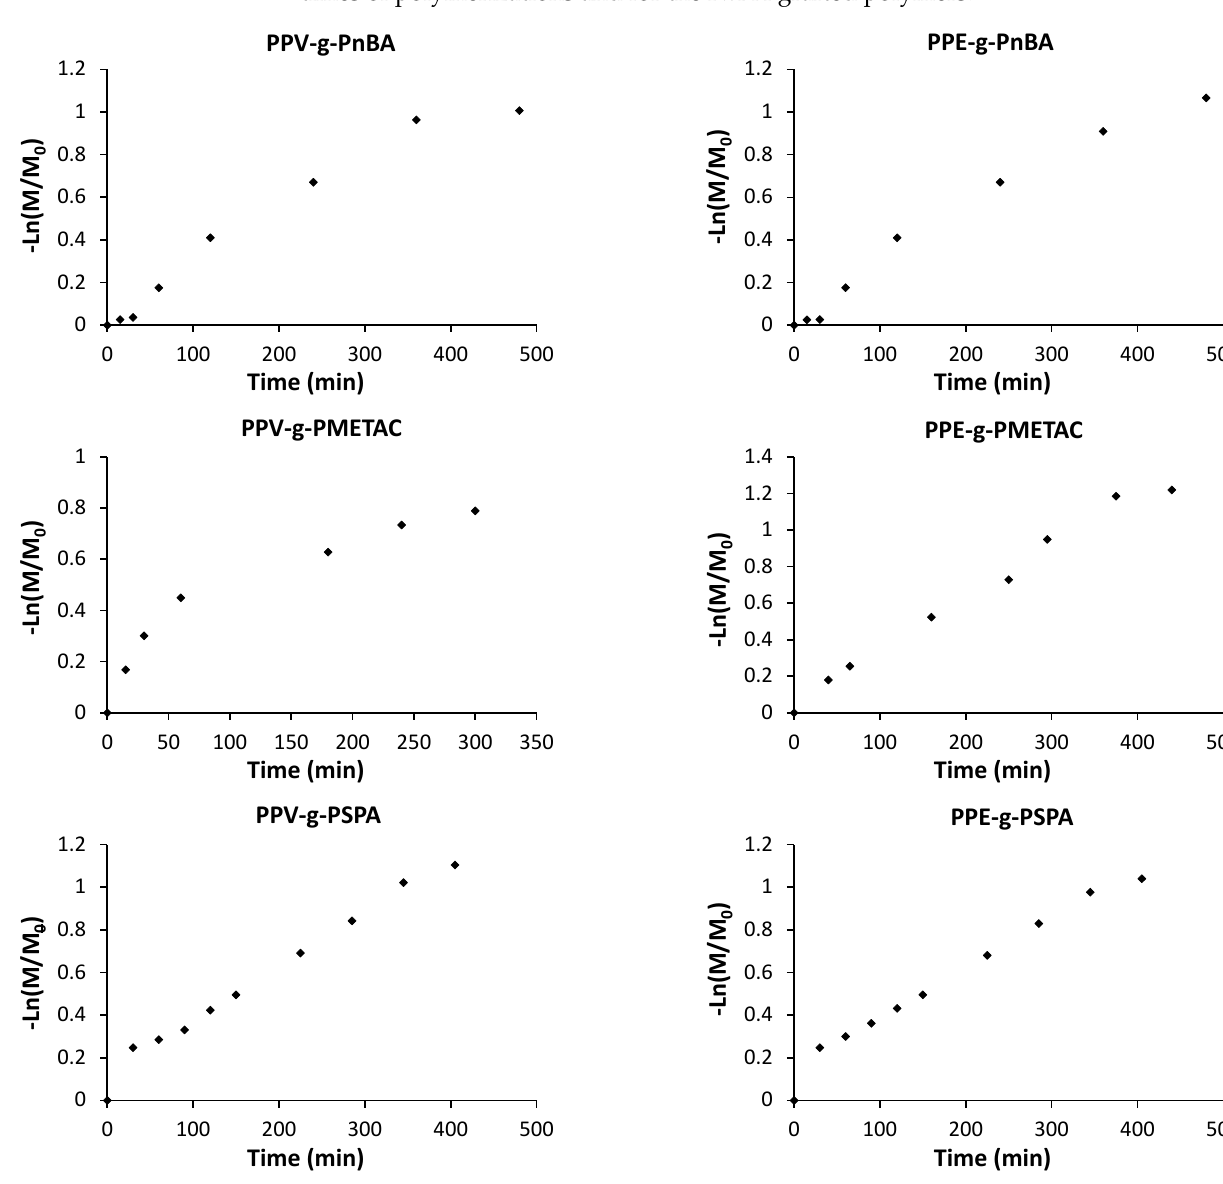
Figure 1. Chemical structures for the PPV and PPE macroinitiators and the resulting polymers.